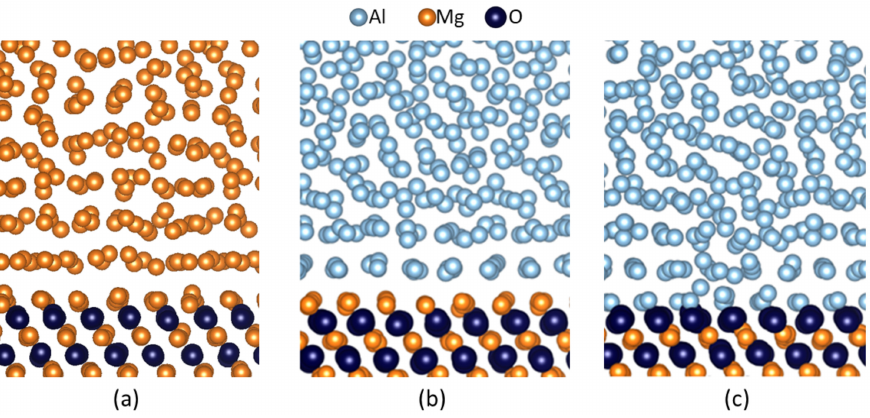
Figure 7. A metal layer terminates the MgO{1 1 1} substrates in the liquid. Snapshots of the equili- brated Mg( l )/MgO{1 1 1} ( a ), Al( l )/MgO{1 1 1} Mg ( b ) and Al( l )/MgO{1 1 1} Al ( c ) systems